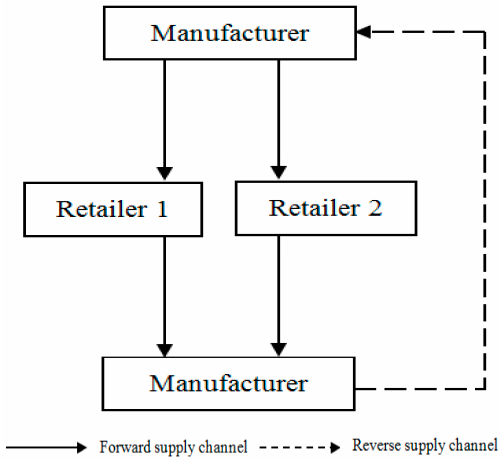
Figure 1. Closed-loop supply chain structure. Figure 1. Closed ‐ loop supply chain structure. Figure 1. Closed ‐ loop supply chain structure.